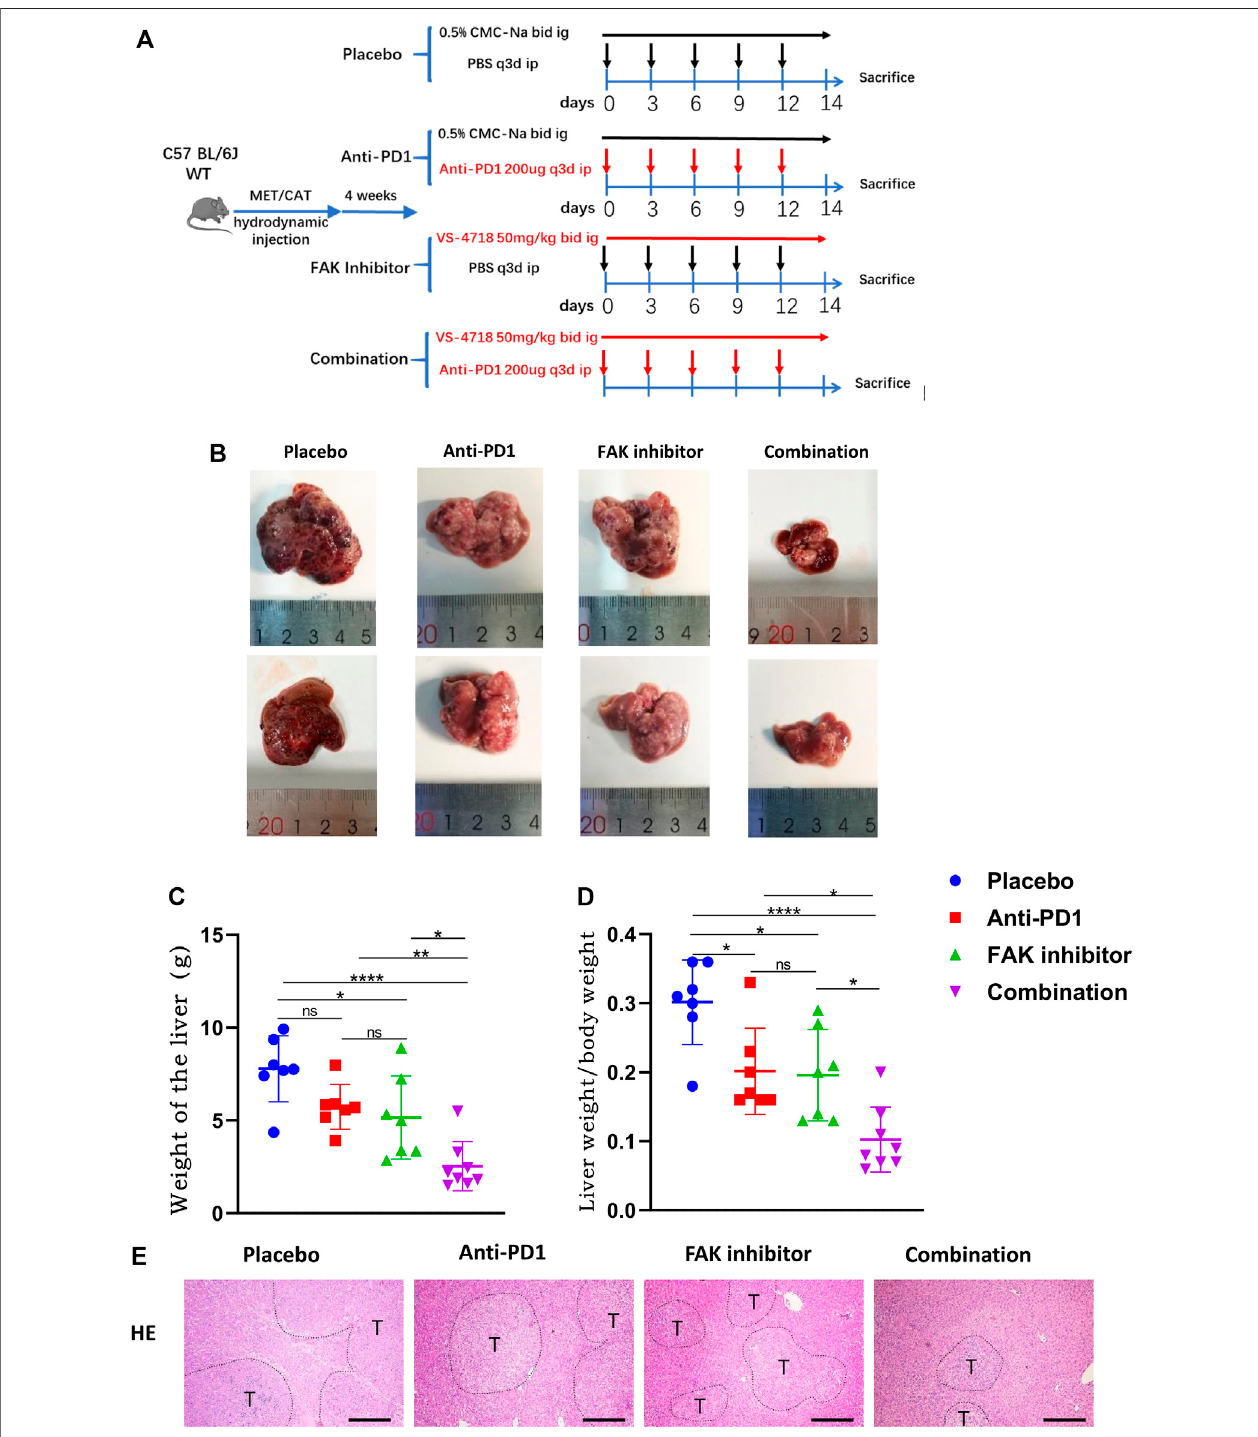
FIGURE2| CombinationofFAKinhibition and anti-PD1 therapy effectively inhibitedthegrowth ofHCC inmice (A) After4 weeks ofplasmid injection inC57BL/6 J mice,aprimaryhepatocellularcarcinomamodelwasestablishedandthemicewererandomlydividedintofourgroups(Placebogroup, n (cid:1) 7;Anti-PD1group, n (cid:1) 7;FAK inhibitor group, n (cid:1) 7; Combination group, n (cid:1) 8), and speci fi c information about the administration (time, dosage, and method). (B) The mouse liver after 2 weeks of medication. (C – D) The liver weight of mice and the liver weight/body weight of mice were compared in each group (Placebo group, n (cid:1) 7; Anti-PD1 group, n (cid:1) 7; FAK inhibitor group, n (cid:1) 7; Combination group, n (cid:1) 8). Signi fi cance identi fi cation: ns, p ≥ 0.05; *, p < 0.05; **, p < 0.01; ***, p < 0.001. (E) HCC tissues of mice were histologically analyzed by H and E staining (scale bars, 400 μ m).